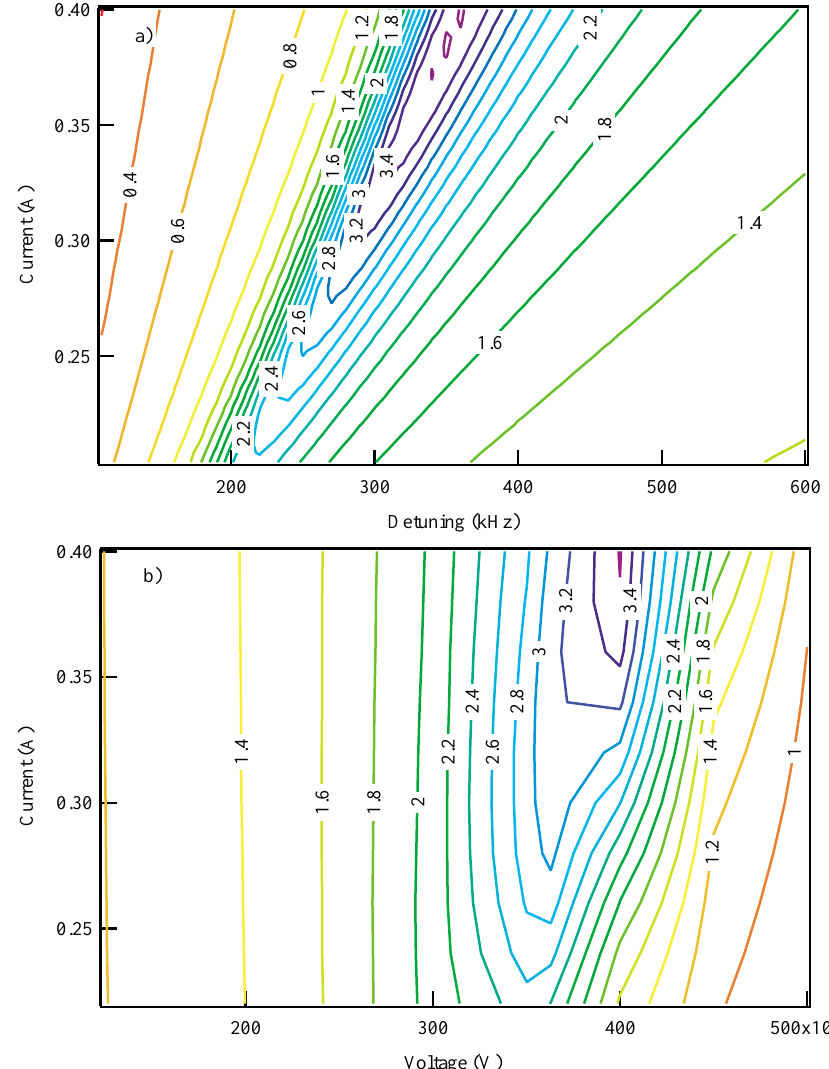
FIG. 5. (Color) Contour plot of the calculated lifetime improvement as a function of beam current and (a) detuning and (b) fixed voltage. Calculations are for three NC cavities and ALS 1.9 GeV